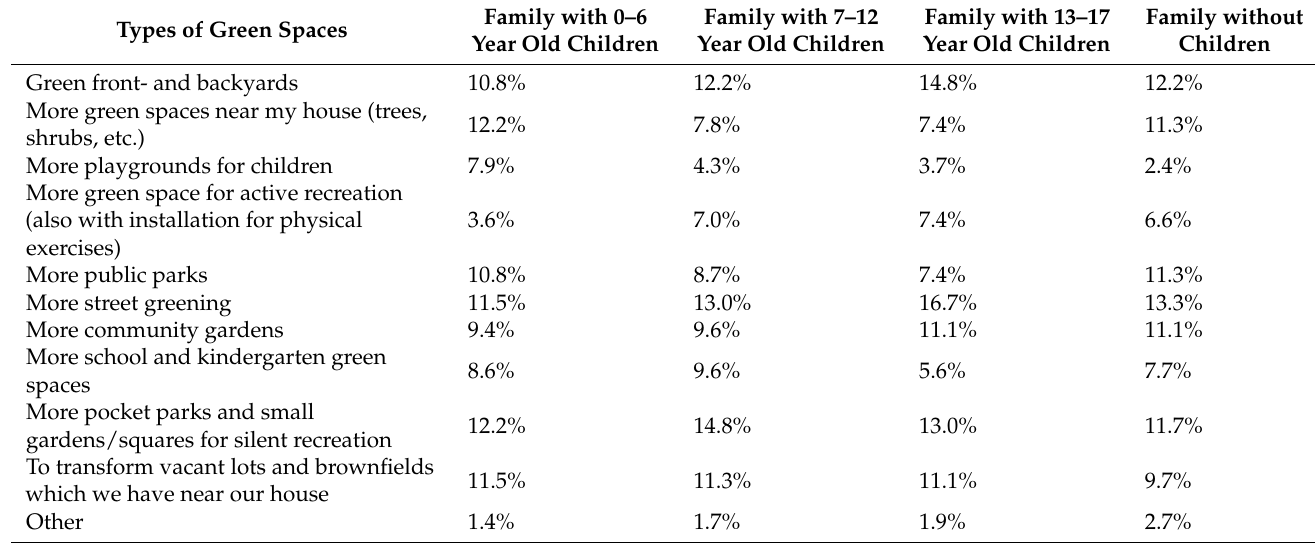
Table 4. Additional required types of UGS mentioned by respondents ( n =